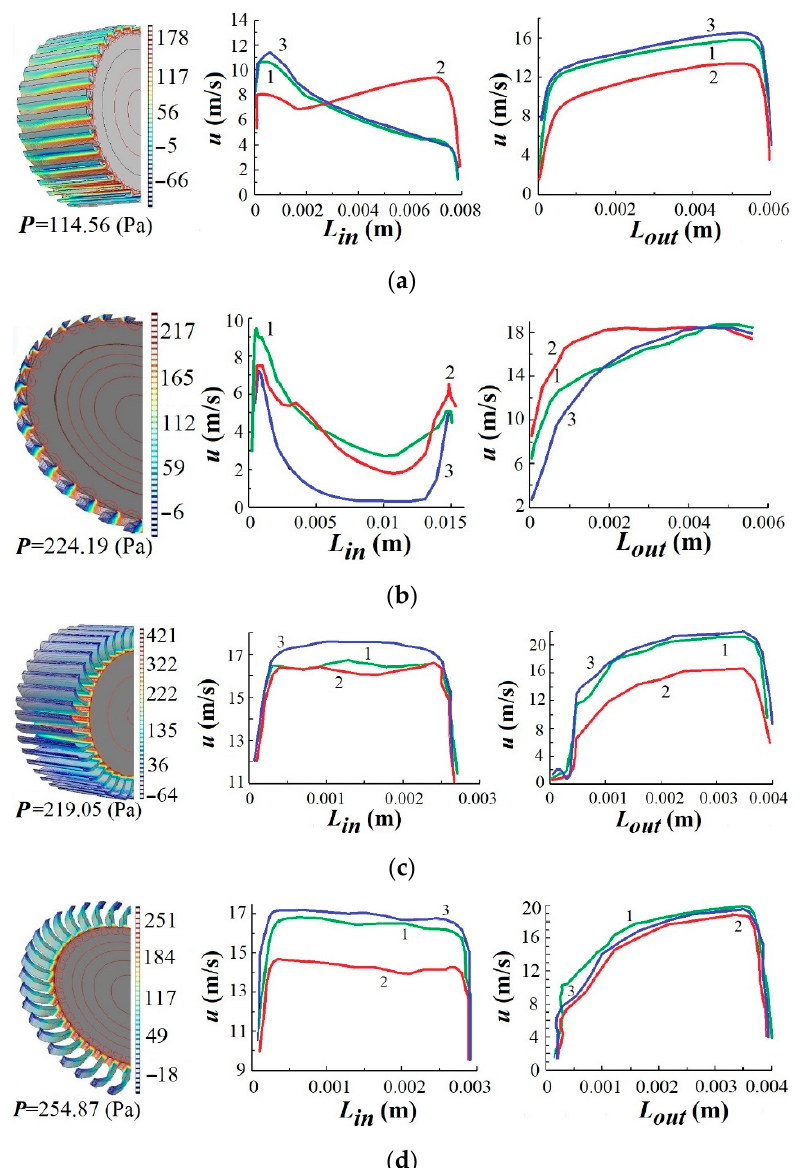
Figure 10. Distribution of pressure drop in straight ( a , b ) and profiled ( c , d ) swirler channels at h = 0.080 (m) ( a , c ) and h = 0.008 (m) ( b , d ) at 𝑢(cid:3364) = 14 (m/s), b = 0.003 (m), and n = 40. Lines (1–3), according to Figure 8.